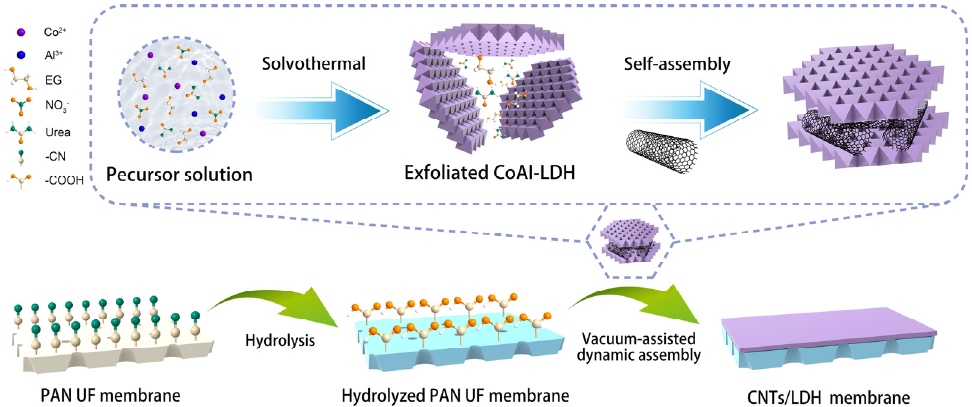
Figure 1. Schematic illustration of the preparation of the CNTs/LDH composite membrane.